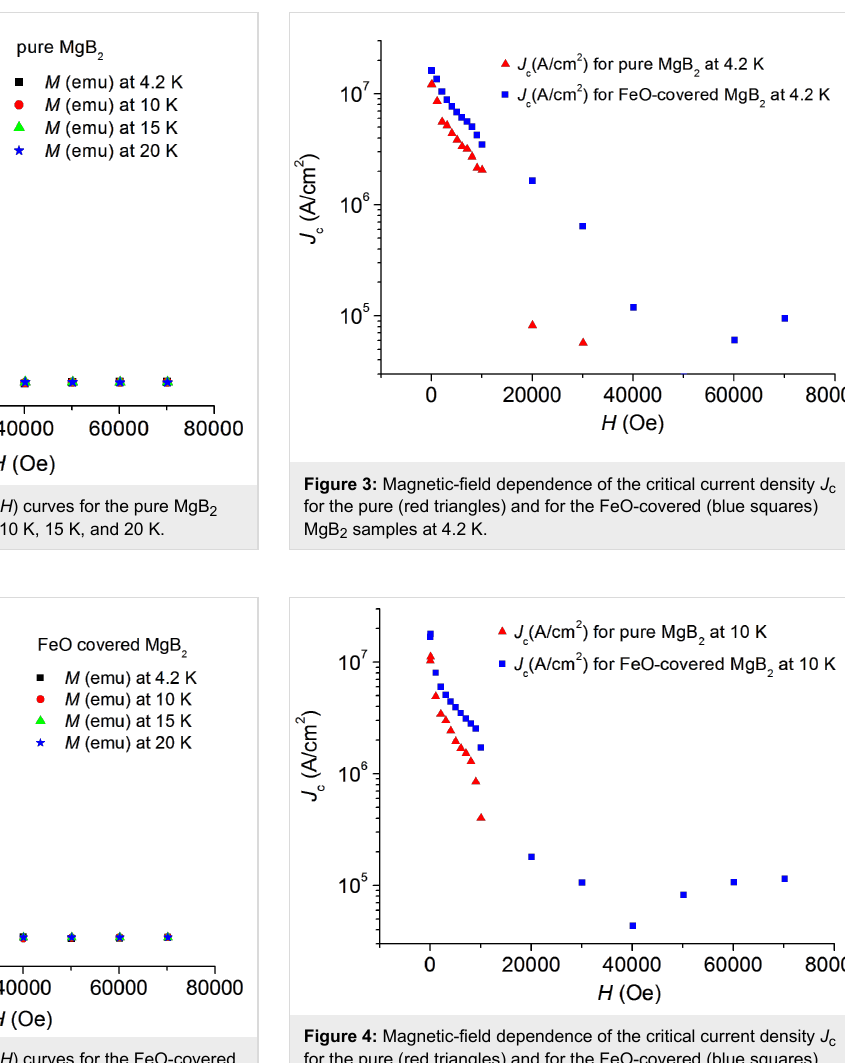
Figure 2: Magnetization hysteresis ( M–H ) curves for the FeO-covered MgB 2 sample at various temperatures: 4.2 K, 10 K, 15 K, and 20 K.